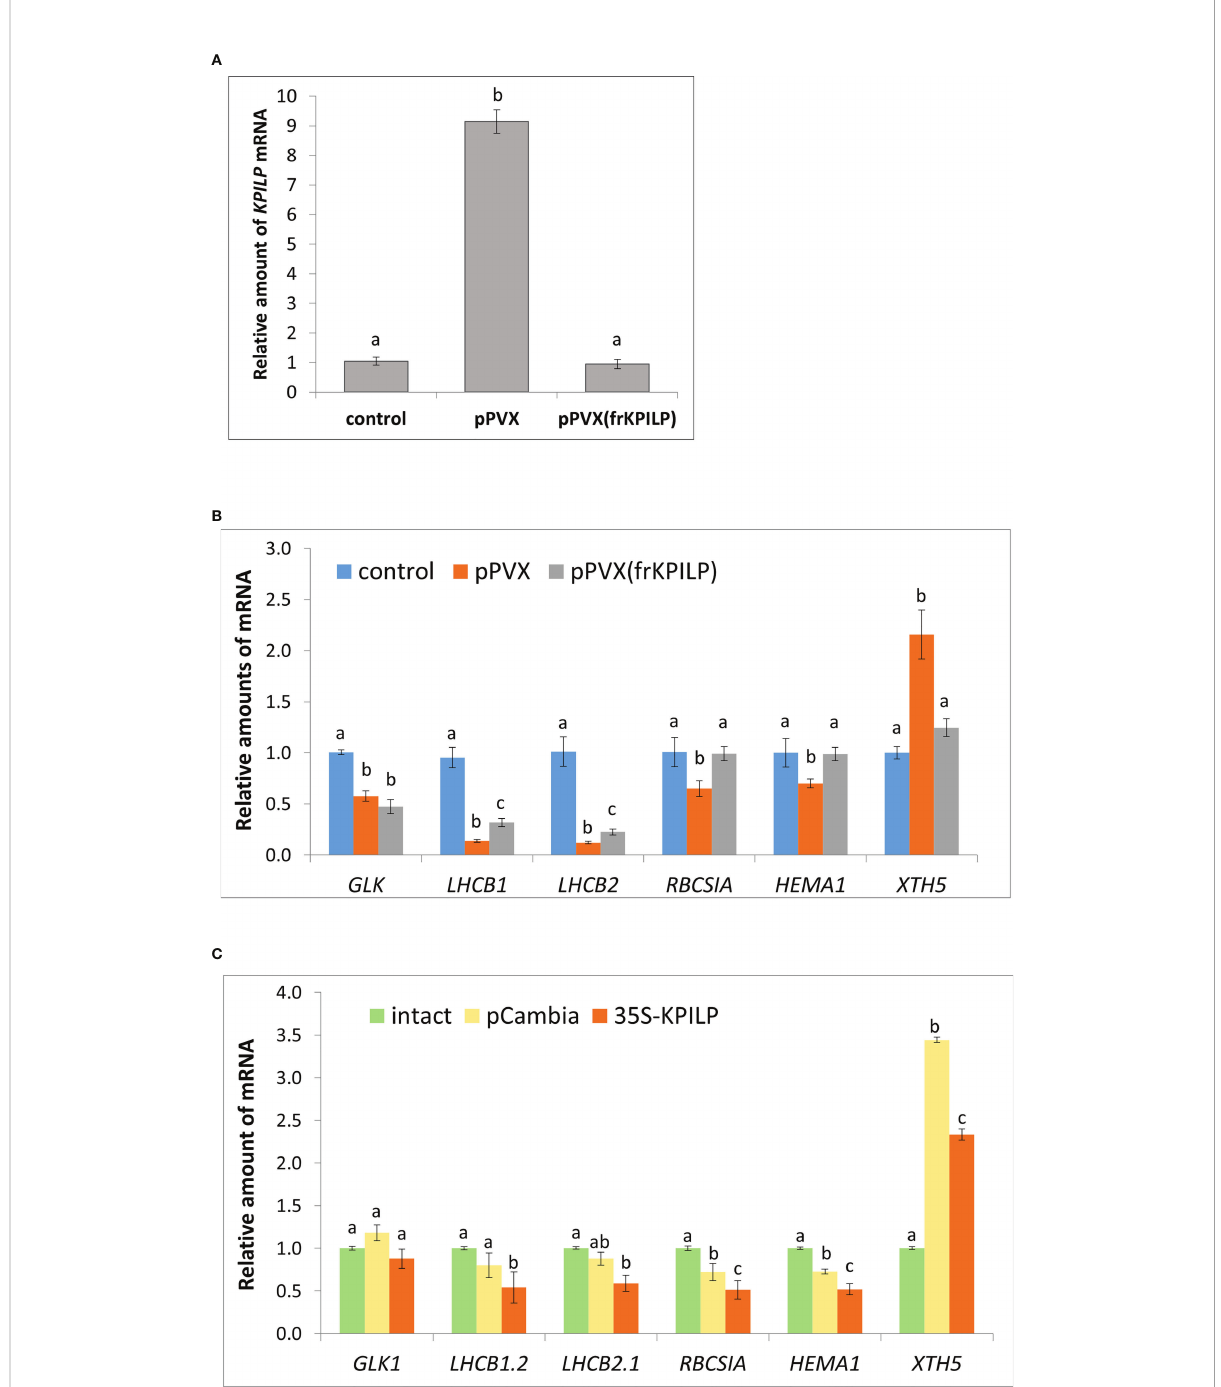
FIGURE 1 KPILP is involved in CRS regulatory hub. (A) Relative amount of KPILP mRNA in leaves with systemic PVX infection (pPVX or pPVX(frKPILP)) as determined by qPCR. Mean values and standard error are presented. The data was analyzed using ANOVA. Bars without shared letters indicate signi fi cant differences according to Tukey ’ s HSD at p<0.05. (B) Relative amount of CRS marker genes mRNA in response to PVX infection and KPILP downregulation as determined by qPCR. Mean values and standard errors are presented. The level of mRNA accumulation for each gene in a control plant was taken as 1. The data was analyzed using Kruskal-Wallis test. Bars with different letter indicate signi fi cant difference according to post-hoc Dunn ’ s test at p<0.05 while bars with shared letter are not signi fi cantly different. (C) Relative amount of CRS marker genes mRNA in leaves 3 days after agroin fi ltration with “ empty ” pCambia1300 or 35S-KPILP as determined by qPCR. Mean values and standard errors are presented. The level of mRNA accumulation for each gene in an intact plant was taken as 1. Bars with different letter indicate signi fi cant difference at p<0.05 (ANOVA, Tukey ’ s HSD), while bars with shared letter are not signi fi cantly